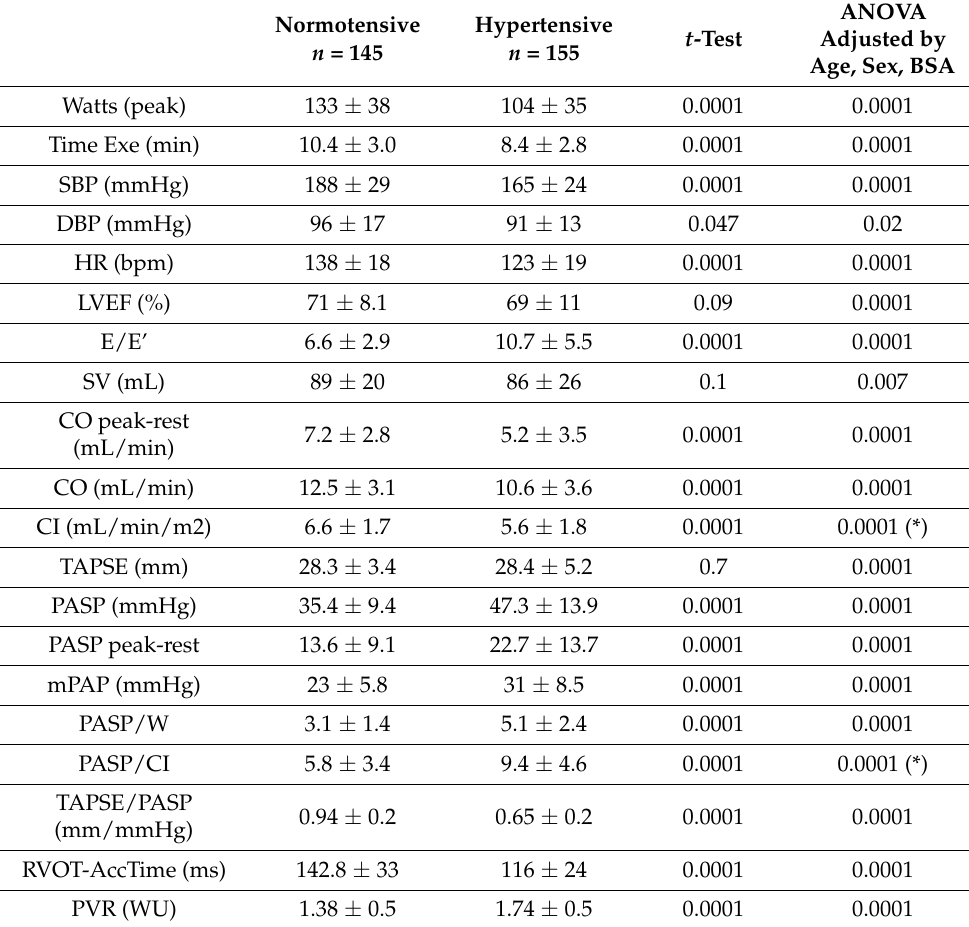
Table 3. Difference between normotensive and hypertensive subjects at peak stress test.